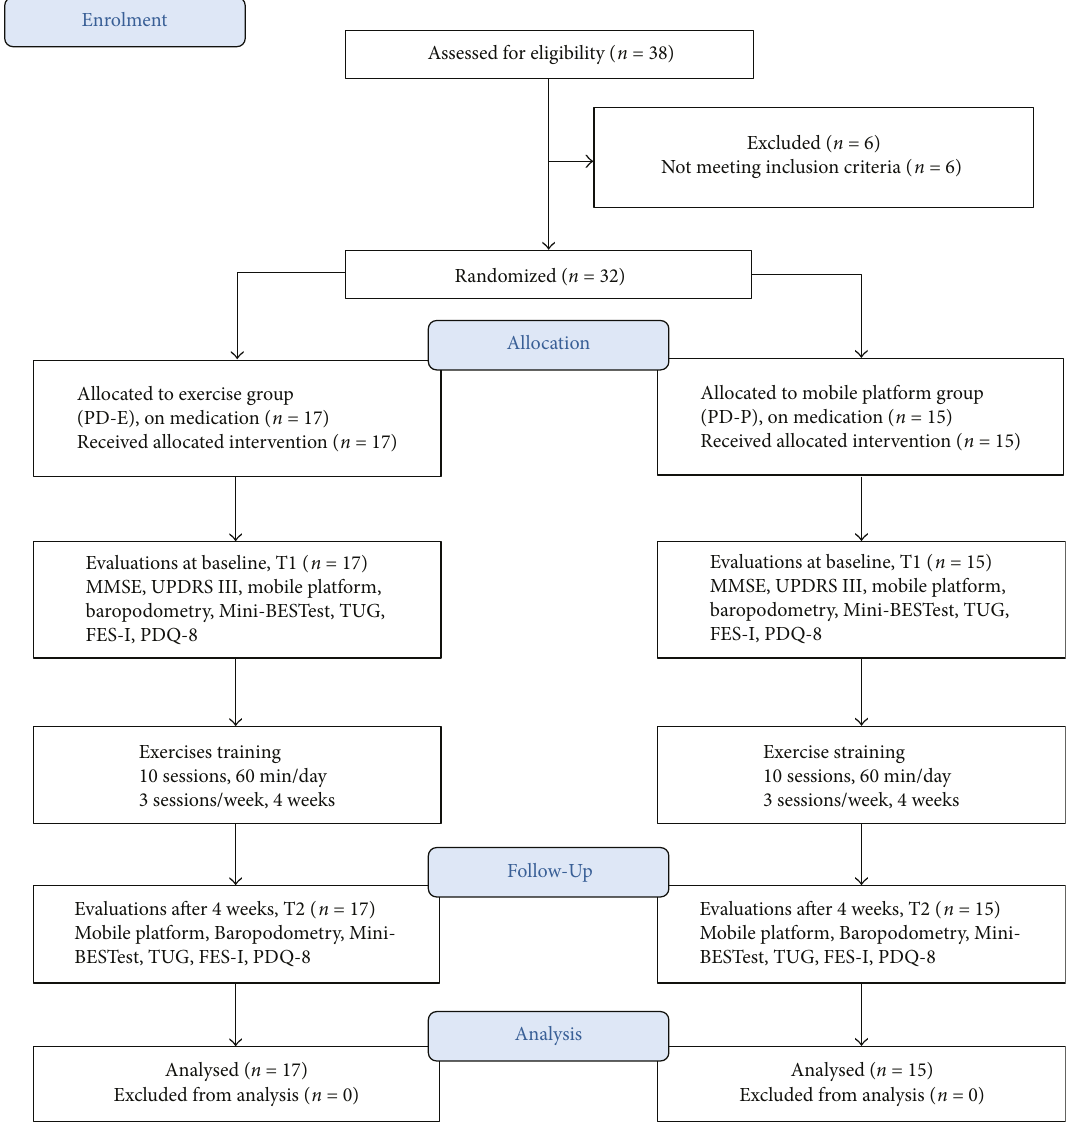
Figure 2: Flowchart for participant inclusion, allocation, evaluations, intervention, and analysis. Abbreviations: MMSE: Mini-Mental State Examination; UPDRS III: Uni fi ed Parkinson ’ s Disease Rating Scale; TUG: Timed Up and Go Test; FES-I: Falls E ffi cacy Scale-International; PDQ-8: Parkinson ’ s Disease Questionnaire, 8